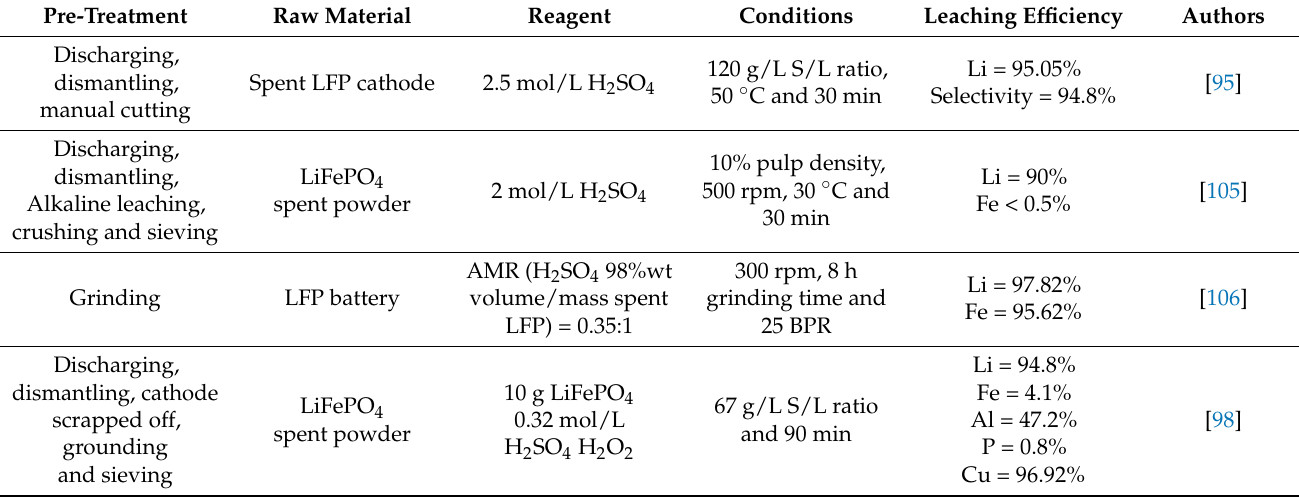
Table 4. Organic acids leaching of LFP